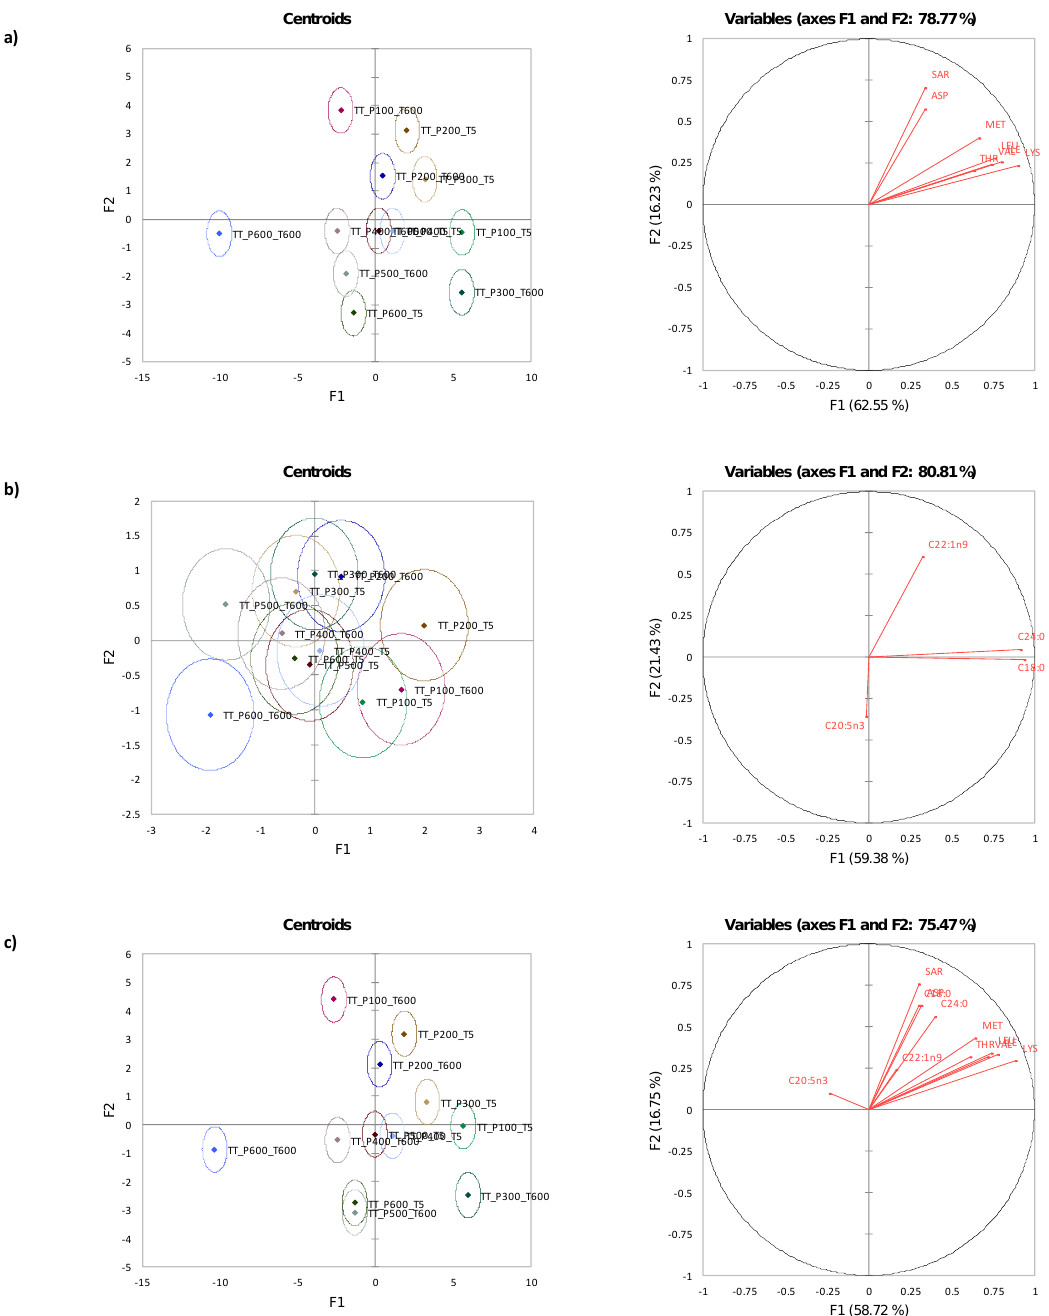
Figure 4. Canonical variate analysis centroids (left) and vectors (right) for ( a ) free amino acids (F (88,410) = 18.129, p < 0.001), ( b ) fatty acids (F (44,222) = 3.069, p < 0.001), and ( c ) both free amino acids and fatty acids (F (132,233) = 12.650, p < 0.001) of Tua Tua ( Paphies donacina ) clam.